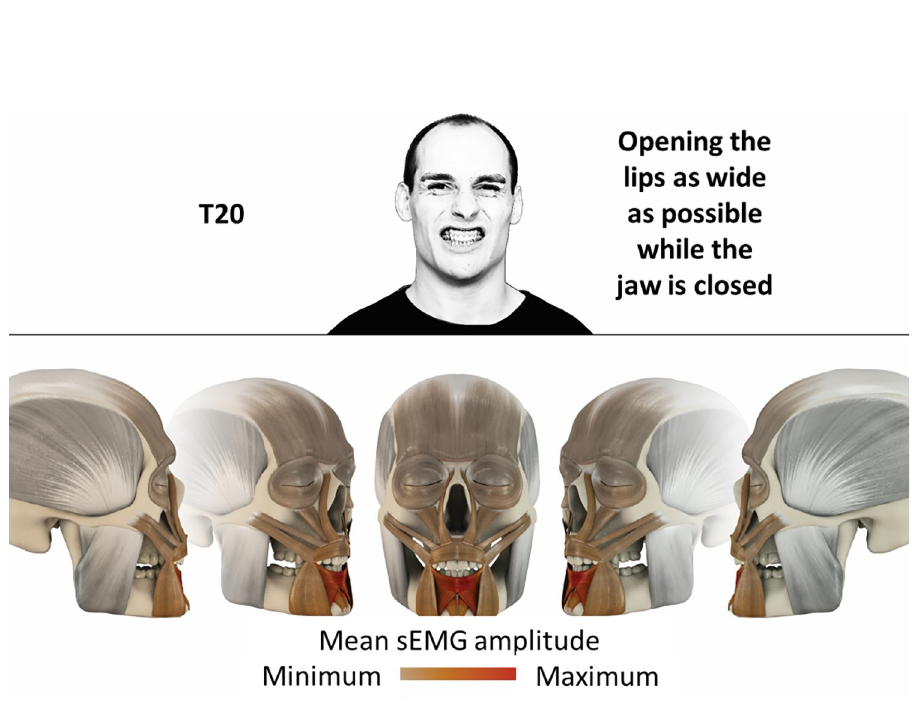
Fig 21. Color-coded facial muscle activation pattern of task T20. Opening lips as wide as possible while the jaw is closed. Animation by Jonas Laustro¨er.